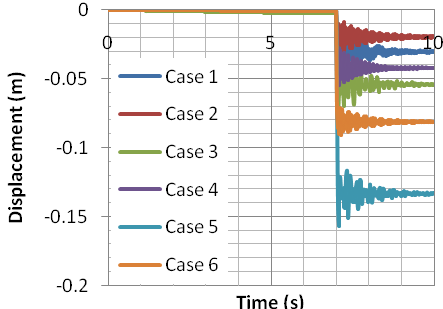
Fig. 11. Vertical displacements of column removal point in 10-storey frame.